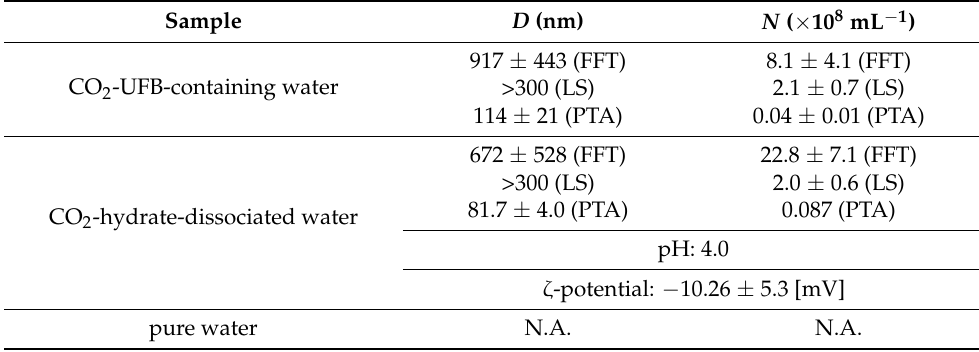
Table 1. Average diameter D and number density N of UFBs in each liquid